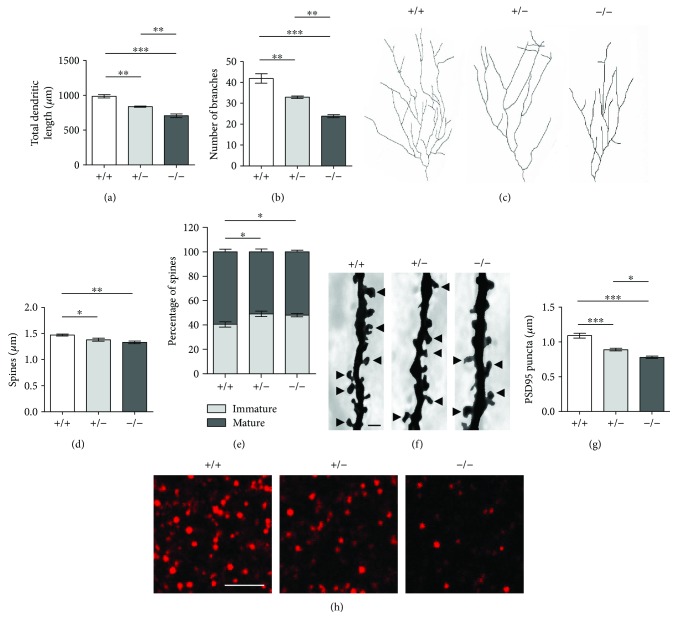
Impaired hippocampal development in Cdkl5 +/− female mice. (a, b) Mean total dendritic length (a) and mean number of dendritic branches (b) of Golgi-stained mature granule neurons of Cdkl5 +/+ (n = 4), Cdkl5 +/− (n = 3), and Cdkl5 −/− (n = 4) mice. (c) Examples of the reconstructed dendritic tree of Golgi-stained mature granule neurons of one animal from each experimental group. (d, e) Dendritic spine density (number of spines per μm; d) and percentage of immature and mature spines (e) in relation to the total number of protrusions of granule neurons of mice as in (a). (f) Examples of Golgi-stained dendritic branches of mature granule neurons of one animal from each experimental group. The black triangles indicate mature spines (mushroom- and cup-shaped spines). Scale bar: 1 μm. (g) Number of fluorescent puncta per μm2 exhibiting PSD-95 immunoreactivity in the molecular layer of the dentate gyrus of Cdkl5 +/+ (n = 4), Cdkl5 +/− (n = 4), and Cdkl5 −/− (n = 3) mice. (h) Confocal images of sections processed for PSD-95 immunohistochemistry of one animal from each experimental group. Scale bar: 2.5 μm. Values represent mean ± SEM. ∗
p < 0.05, ∗∗
p < 0.01, and ∗∗∗
p < 0.001 (datasets in (a–c, e–h), Fisher's LSD test after ANOVA; datasets in (d), Dunn's test after Kruskall-Wallis).